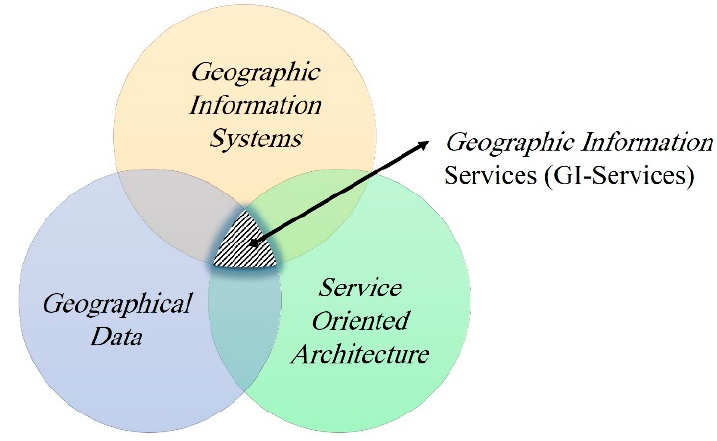
Figure 1. A paradigm shift from Geographic Information (GI) ‐ systems to GI ‐ Services.